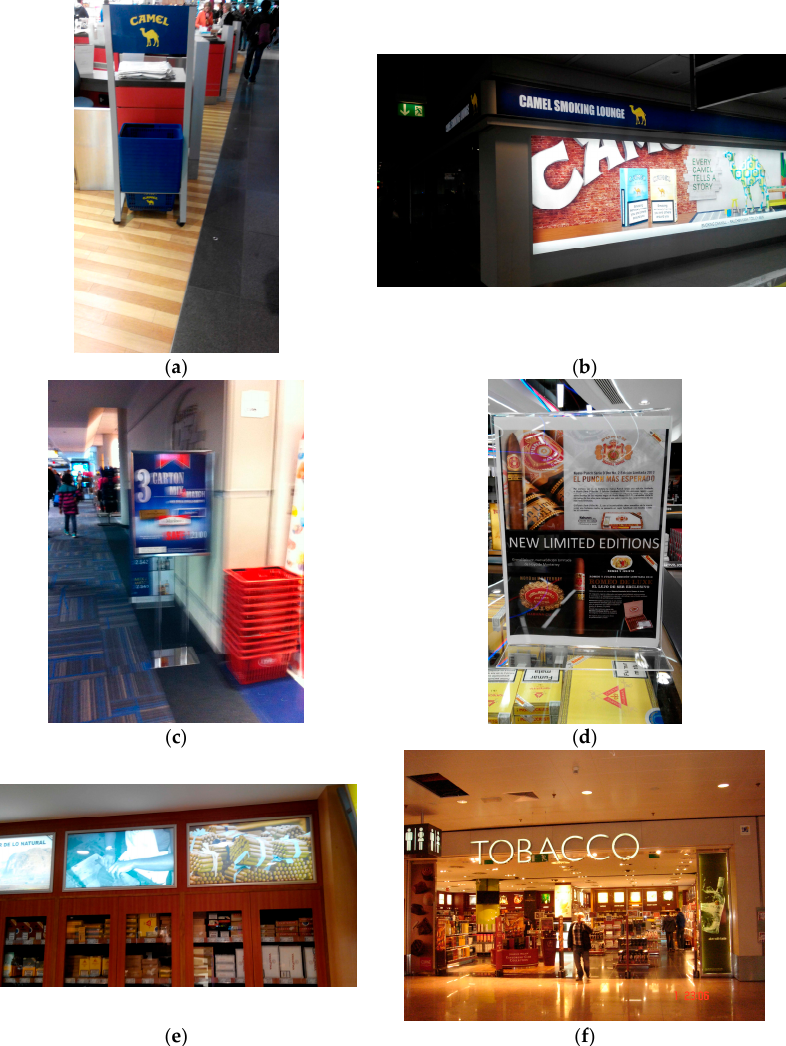
Figure 2. Selected photos from airport observations, 2014. ( a ) Munich airport shopping baskets; ( b ) Munich airport smoking lounge; ( c ) Dulles airport promotion; ( d ) Madrid airport promotion; ( e ) Madrid airport tobacco product display; ( f ) Brussels airport tobacco retail